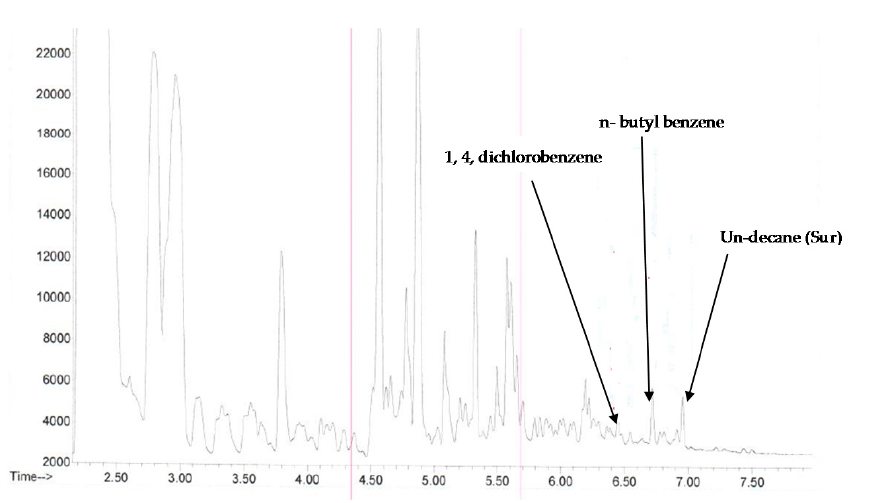
Figure 14. FID-GC from 15 g of LDPE.